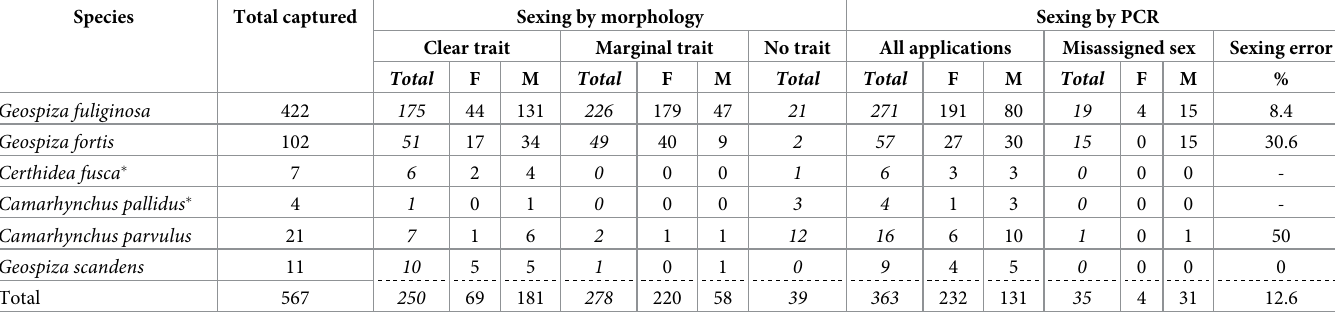
Table 4. Adult and juvenile Darwin’s finches captured and sexed by morphology or later resolved by PCR.